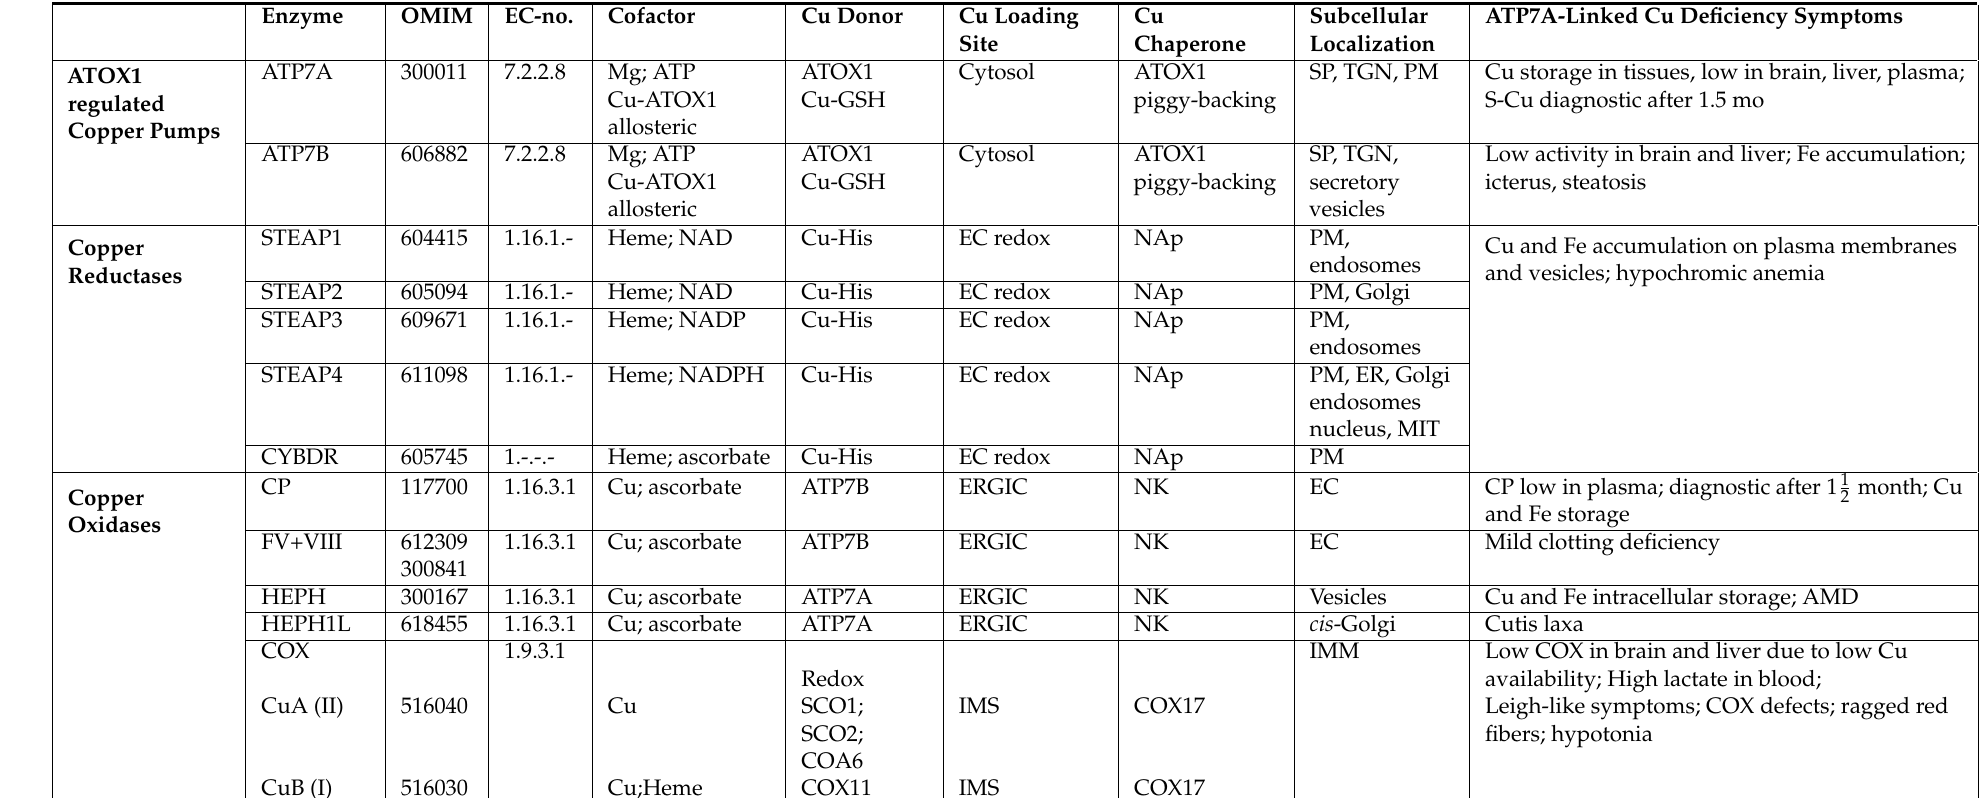
Table 2. Copper-dependent Enzymes and basic